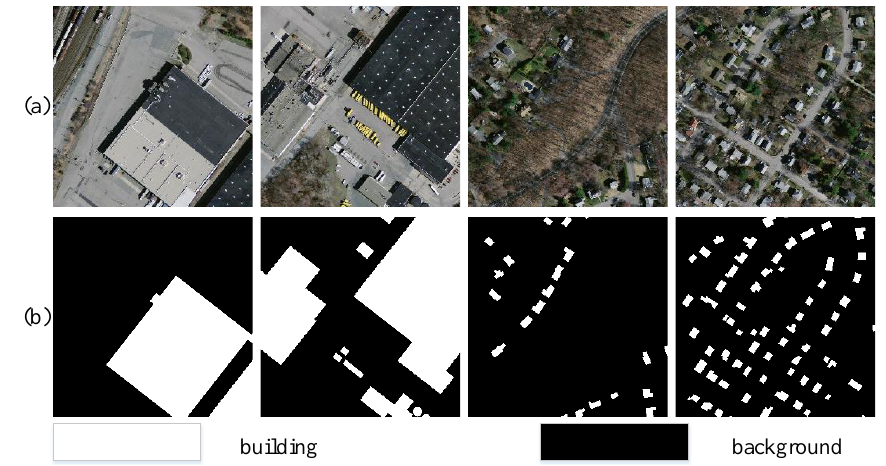
Figure 8. Public dataset. ( a ) Original image; ( b ) artificial